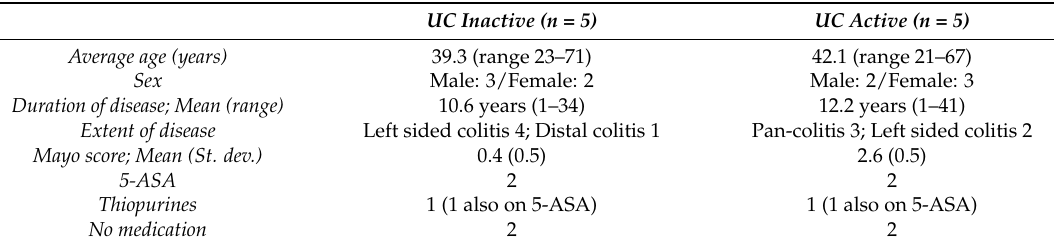
Table 3. Demographic data of patients used for epithelial cell isolation. n: number of subjects; St. dev.: standard deviation; 5-aminosalicylic acid: 5-ASA.